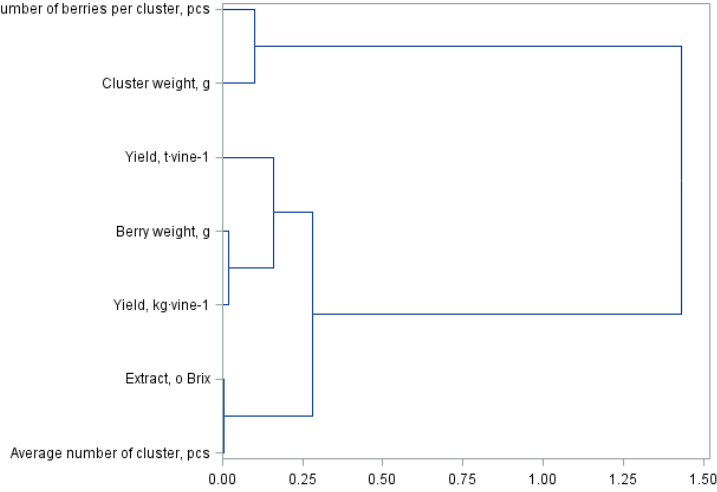
Figure 1. Branching-tree diagram of yield and quality parameters of self-rooted Regent variety vines.